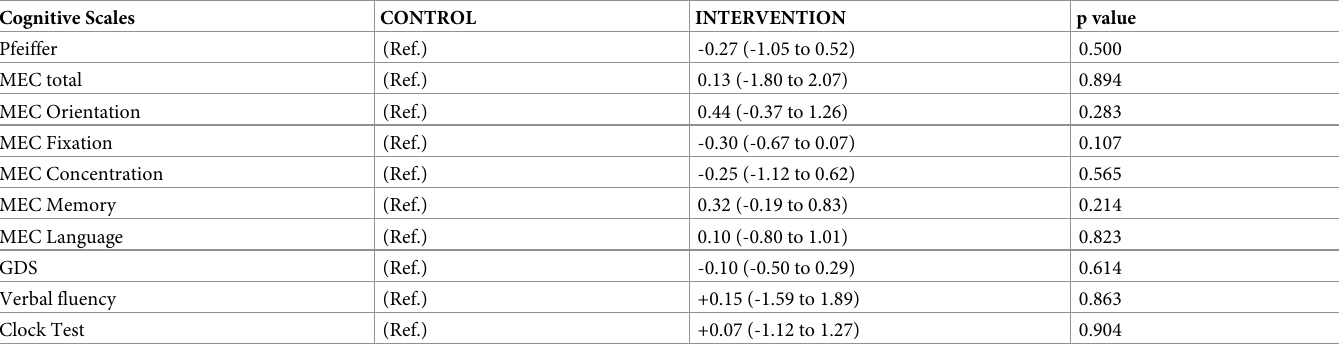
Table 4. Adjusted (cid:3) mean differences of cognitive scales after 1 year of follow-up between control and intervention group. Cognitive Scales